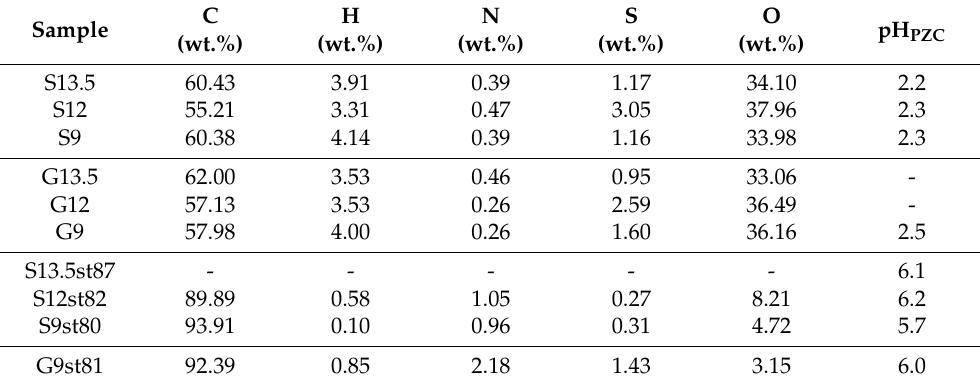
Table 1. Elemental analysis and pH PZC values of acid-chars and derived activated